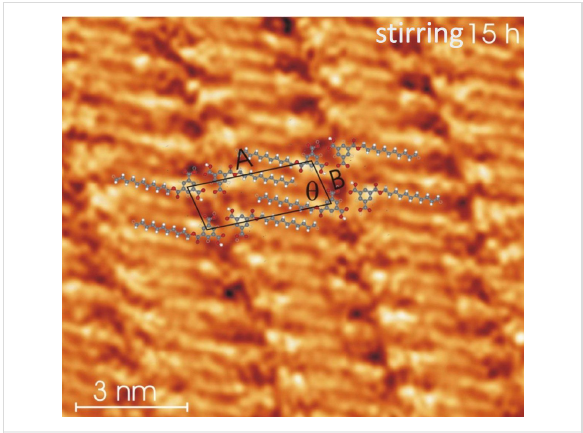
Figure 4: STM constant current image (1.1 V, 1 nA) of TMA–monoundecyl ester type-I obtained from a TMA–undecanol